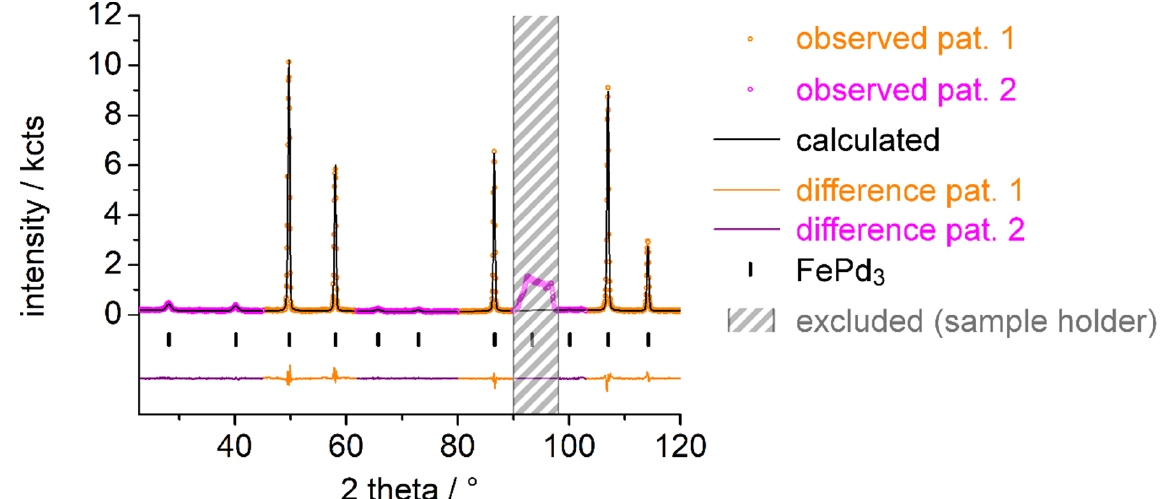
Figure A8. Rietveld refinement of the crystal structure of FePd 3 (for details, see first row in Tables A6 and A7) based on neutron powder diffraction data (NUMOR 131613 [21], λ =186.80(2) pm, D20 ILL, Grenoble) in a single-crystal sapphire cell at 296(1) K and applied vacuum ( 0.0001(10) MPa) using FullProf [24].